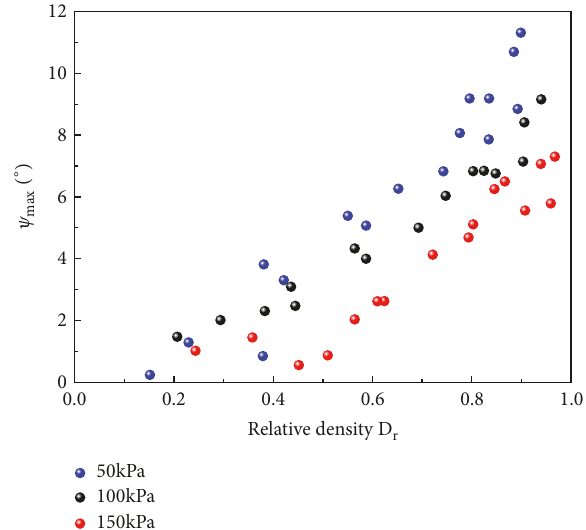
Figure 11: Maximum dilatancy angle versus relative density at different normal stress.